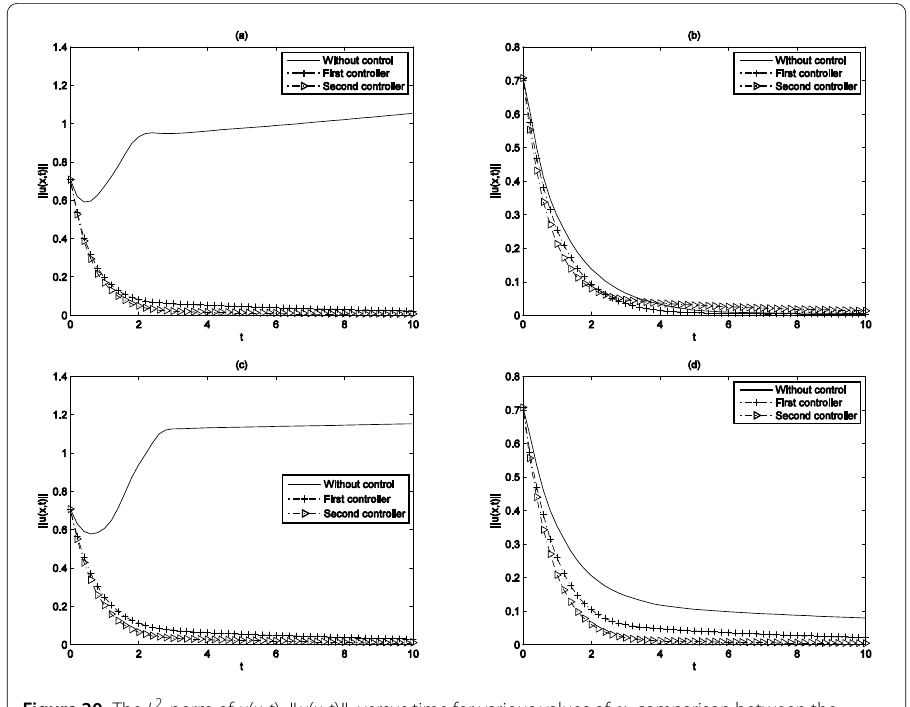
Figure 20 The L 2 -norm of u ( x , t ), (cid:7) u ( x , t ) (cid:7) , versus time for various values of α ; comparison between the behavior of the equation with and without control when v = 0.01, μ = 0.001, γ 1 = 1, γ 2 = 0.0005 and u 0 ( x ) = sin(2 π x ); ( a ) α = 1; ( b ) α = 2; ( c ) α = 3; ( d ) α =